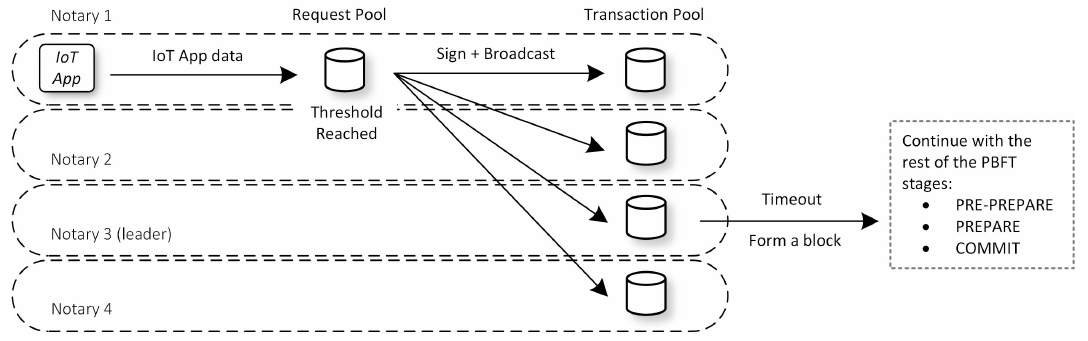
Figure 3. The request aggregation strategy in the Core Engine. We use a request pool mechanism to aggregate mulitple IoT app data requests and sign them altogether before broadcasting to other Notary